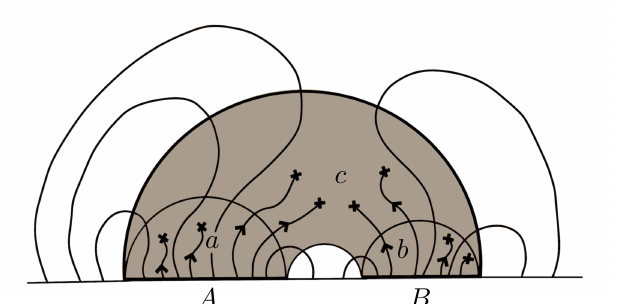
Figure 3 . Thread representation of the max flow associated to a boundary region made out the two simply connected parts A and B . Above, we have defined a , b and ab as the bulk homology regions associated with A , B and AB , respectively, and c = ab \ a ∪ b . The entropy density on a , b and c is picked to be positive and thus acts as sinks for the quantum threads. When restricted to the region a ∪ b , though, some of these threads (the ones ending on c ) are interpreted as classical because they contribute exclusively to the area ∂ ( a ∪ b )